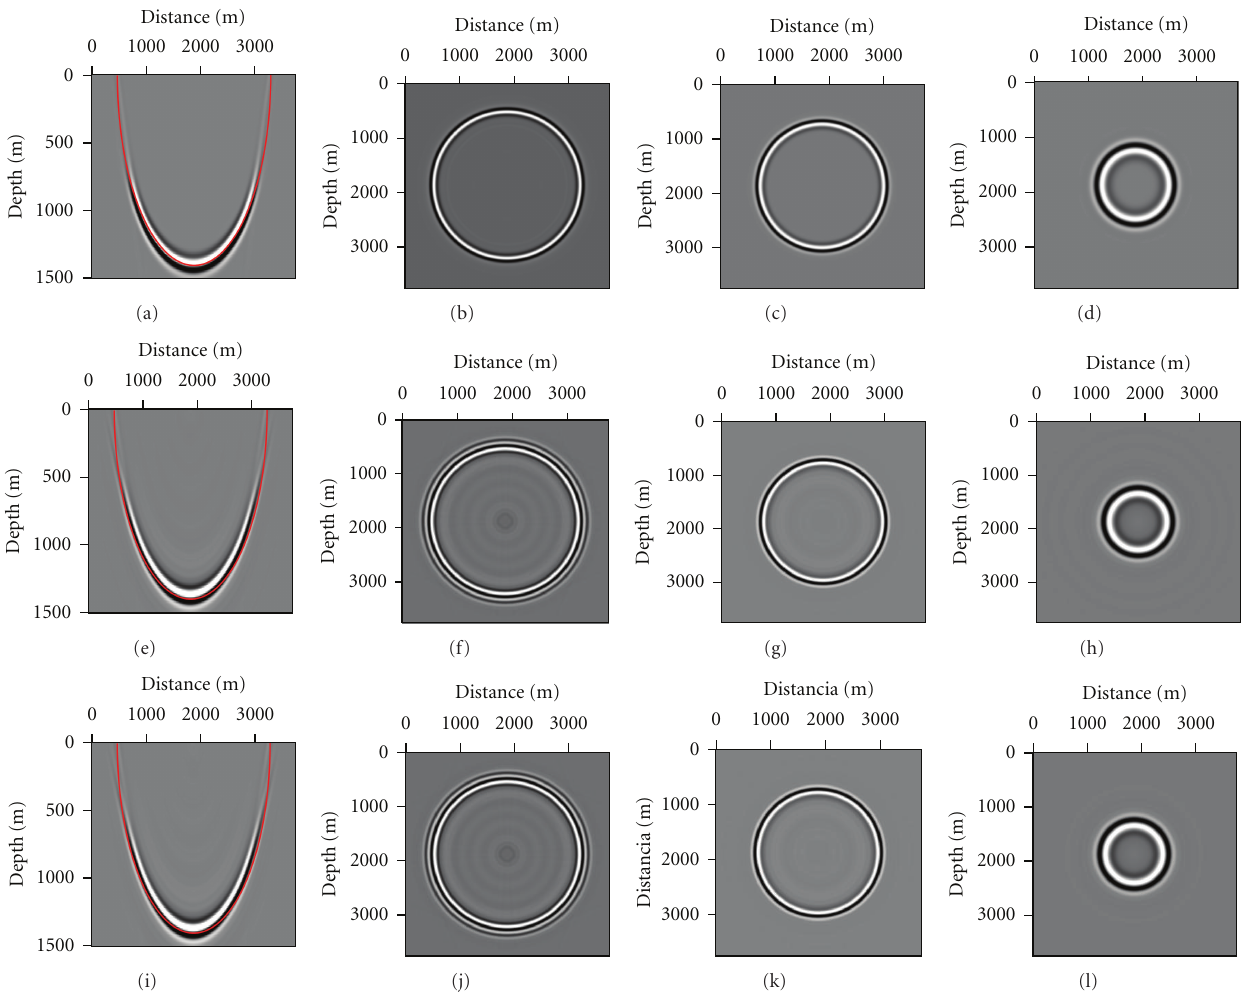
Figure 2: Migration impulse responses. (a)–(d): FFD migration using alternating four-way splitting; p = 0 . 75. (e)–(h): FFDPI migration using conventional two-way splitting, with interpolation between p = 0 . 9 and p = 1 . 1. (i)–(l): FFDPI migration using alternating four-way splitting, with interpolation between p = 0 . 9 and p = 1 . 1. From left to right: central vertical cut in the x - z plane and horizontal cuts at 150m, 750m, and 1250 m